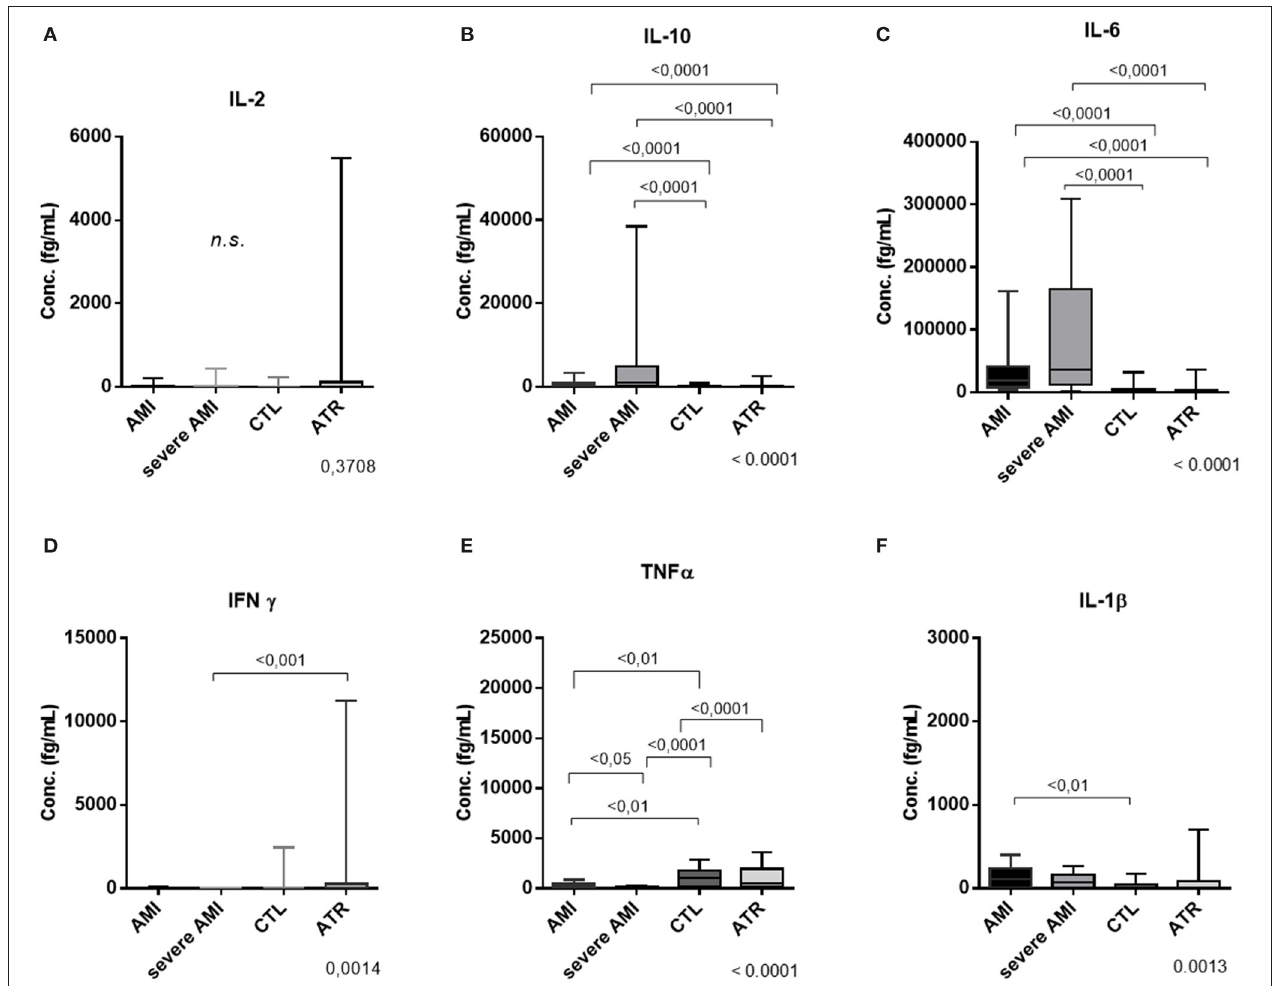
FIGURE 7 | Concentrations of cytokines (fg/mL) in the sera of patients in the different study groups—analysis performed by flow cytometry (CBA). The progression of atherosclerotic disease and the severity of the infarction promote an inflammatory response exacerbated mainly by the IL-6 and IL1B pathways, but the compensation mechanism by IL-10 is not sufficient to contain the inflammation. (A) IL-2, (B) IL-10, (C) IL-6, (D) IFN- γ , (E) TNF α , (F) IL-1 β . (AMI n = 40, severe AMI n = 34, CTL n = 34, ATR n = 40) (data are expressed as median and interquartile range 25–75%). Comparison by Kruskal-Wallis with Dunn applied as a